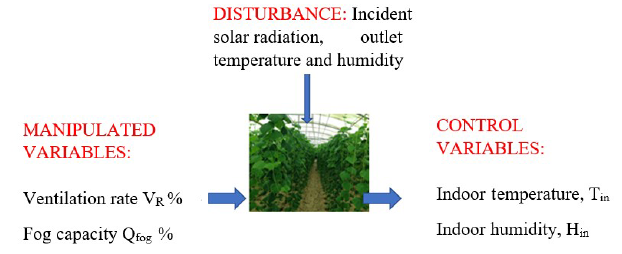
Figure 2. Block Diagram of Greenhouse